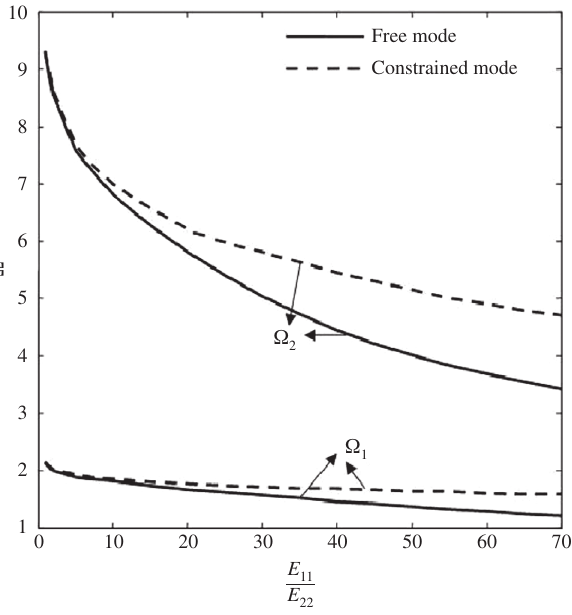
Figure 10 Effect of material anisotropy on the first two frequen- cies of the delaminated LCB with movable hinged-hinged boundary